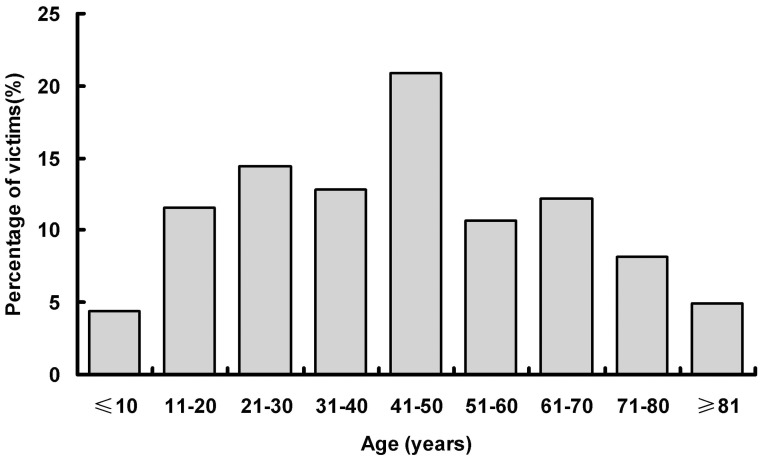
Age distribution of victims.